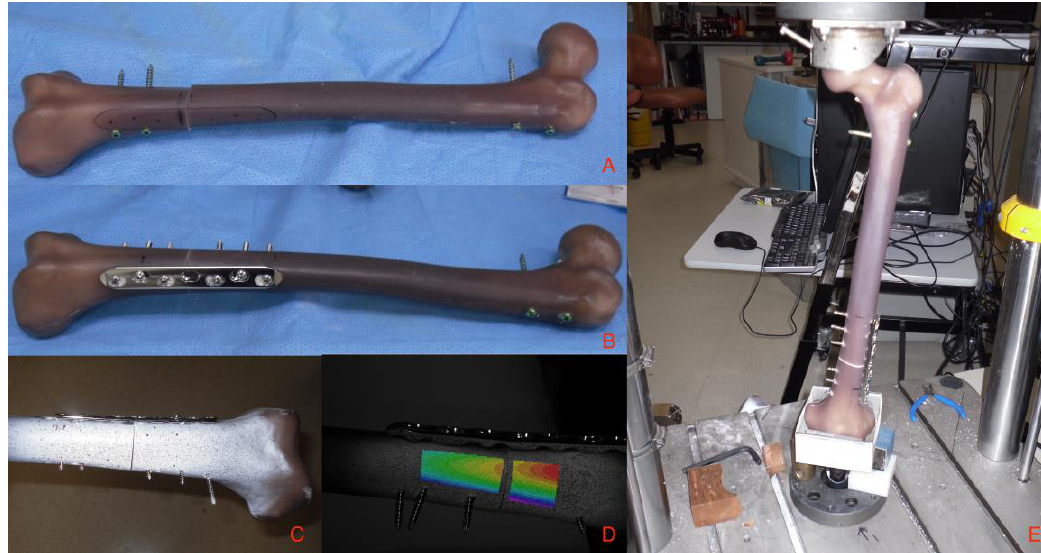
Figure 1. Test setting. ( A ) Preparation of the sawbone femora, with the nail in situ and an artificial fracture applied. ( B ) An additional plate is mounted. ( C ) The anterior surface of the bone is sprayed with a speckle pattern. ( D ) The system allows full-field 3D-surface strain and motion detection down to 200 µstrain. ( E ) Sawbone femora are potted in PMMA distally and held by a universal joint that constrained translation and axial torsion but allow rotation in the other two axes. The femoral head is held in a custom fixture rigidly attached to the load cell. The axis of the bone is aligned in 7° valgus to the rotational axis of the testing machine to recreate a loading situation as close to physiology as possible.